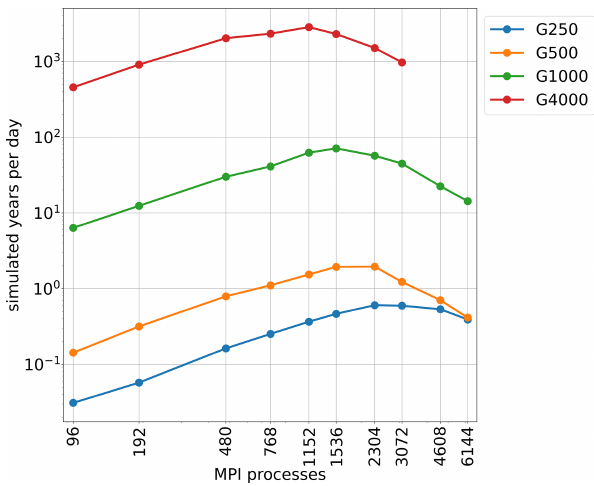
Figure 8. SYPD for various grid resolutions estimated from a run- time of 20 time